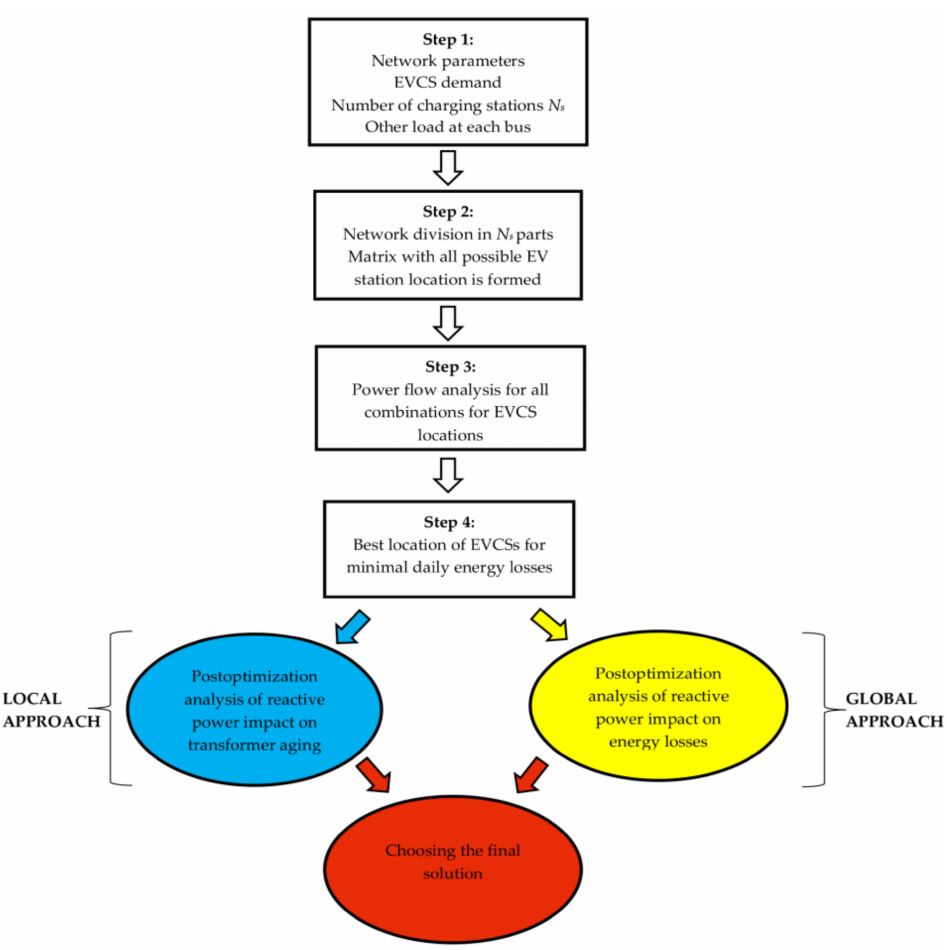
Figure 7. Flowchart of proposed